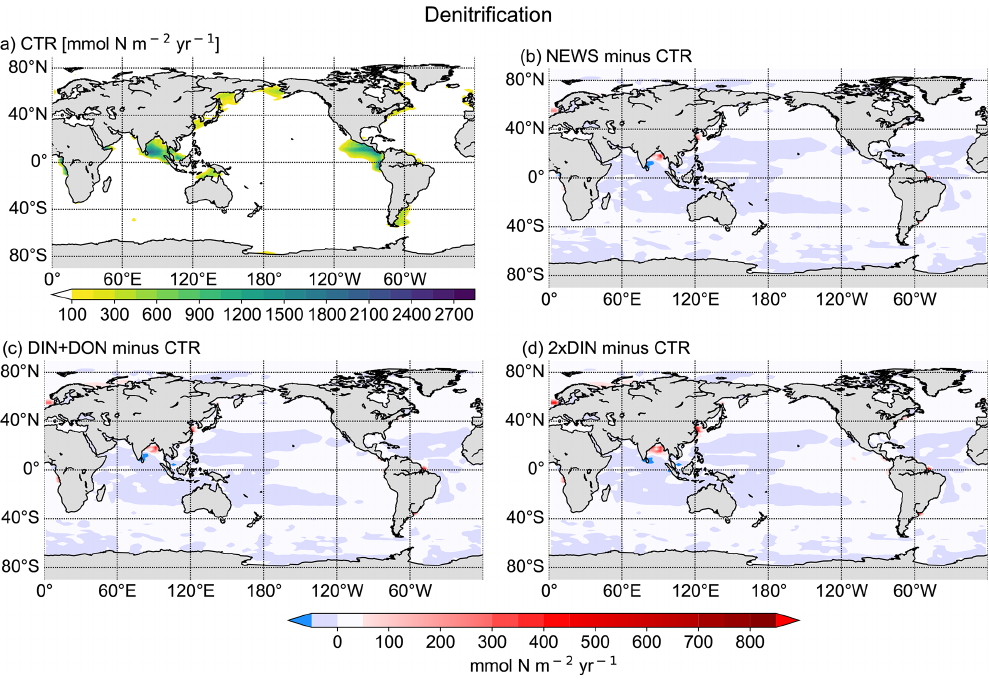
Figure 9. (a) Global distribution of total denitrification in CTR in mmolNm − 2 yr − 1 . The white areas show regions where rates are smaller than 100mmolNm − 2 yr − 1 . (b) Difference in annual vertically integrated rates of total denitrification calculated from UVic NEWS and CTR in mmolNm − 2 yr − 1 . (c) Difference in total denitrification in the simulation with riverine DIN and DON. (d) Difference in total denitrification in the simulation with twice the amount of DIN. Table 4. Mean annual depth-integrated NPP from model data and